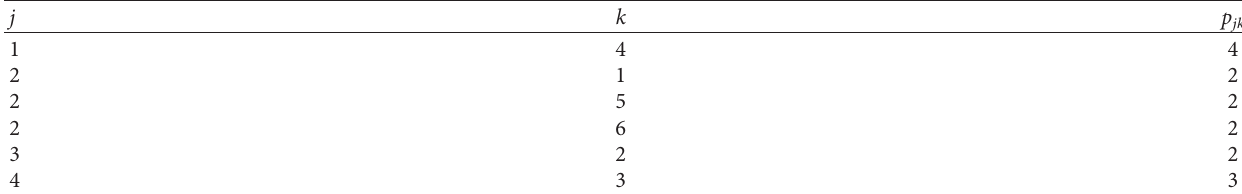
Table 5: Amount of products produced when a tool is set